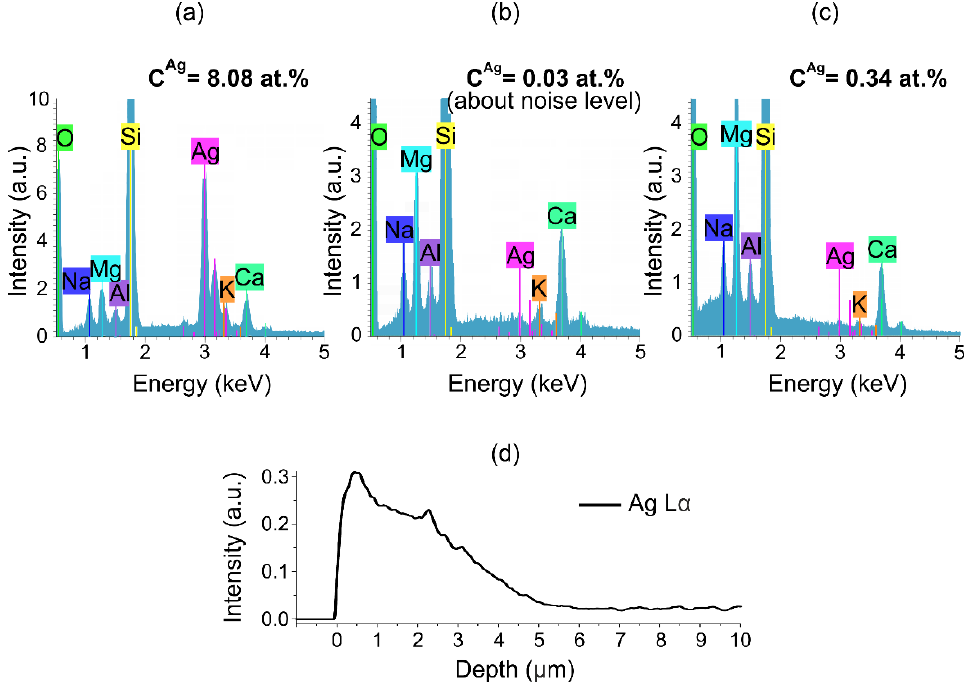
Figure 3. EDS spectra of ( a ) non-poled ion-exchanged glass surface, ( b ) vacuum-poled and ion-exchanged glass surface before and ( c ) after ~400 nm layer was etched off. ( d ) The dependence of normalized intensity of Ag L α line (normalization by intensity of Si K α line) on distance from the surface of poled sample.